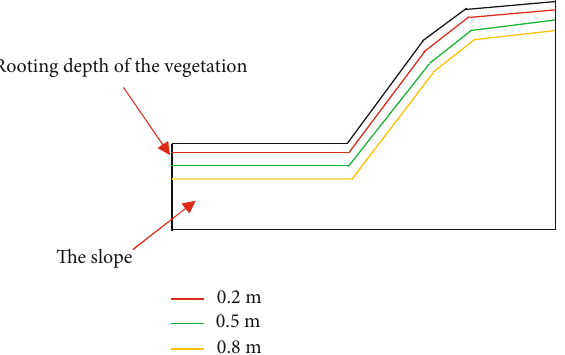
Figure 16: Schematic diagram of the vegetation rooting depth on the slope.